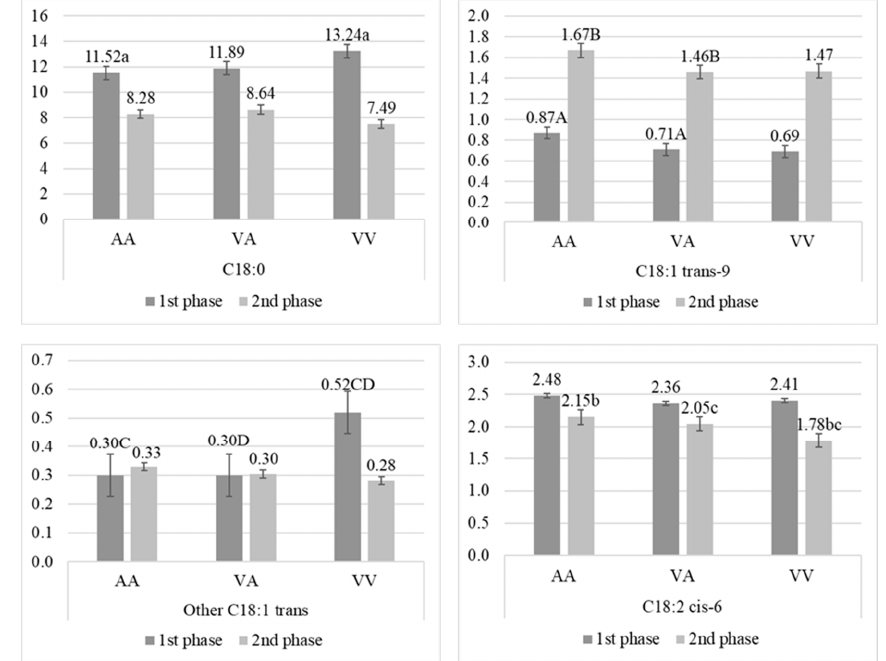
Figure 4. Percentage (mean ± SE) of fatty acids with 18 carbon atoms in milk from Polish Holstein-Frisian cows during first and second phase of lactation depending on A293V single nucleotide polymorphism (SNP) in stearoyl-CoA desaturase ( SCD1 ) gene. a, b, c, d—values differ significantly between polymorphisms within fatty acid ( p < 0.05); A, B, C, D—values differ highly significantly between polymorphisms within fatty acid ( p < 0.01).